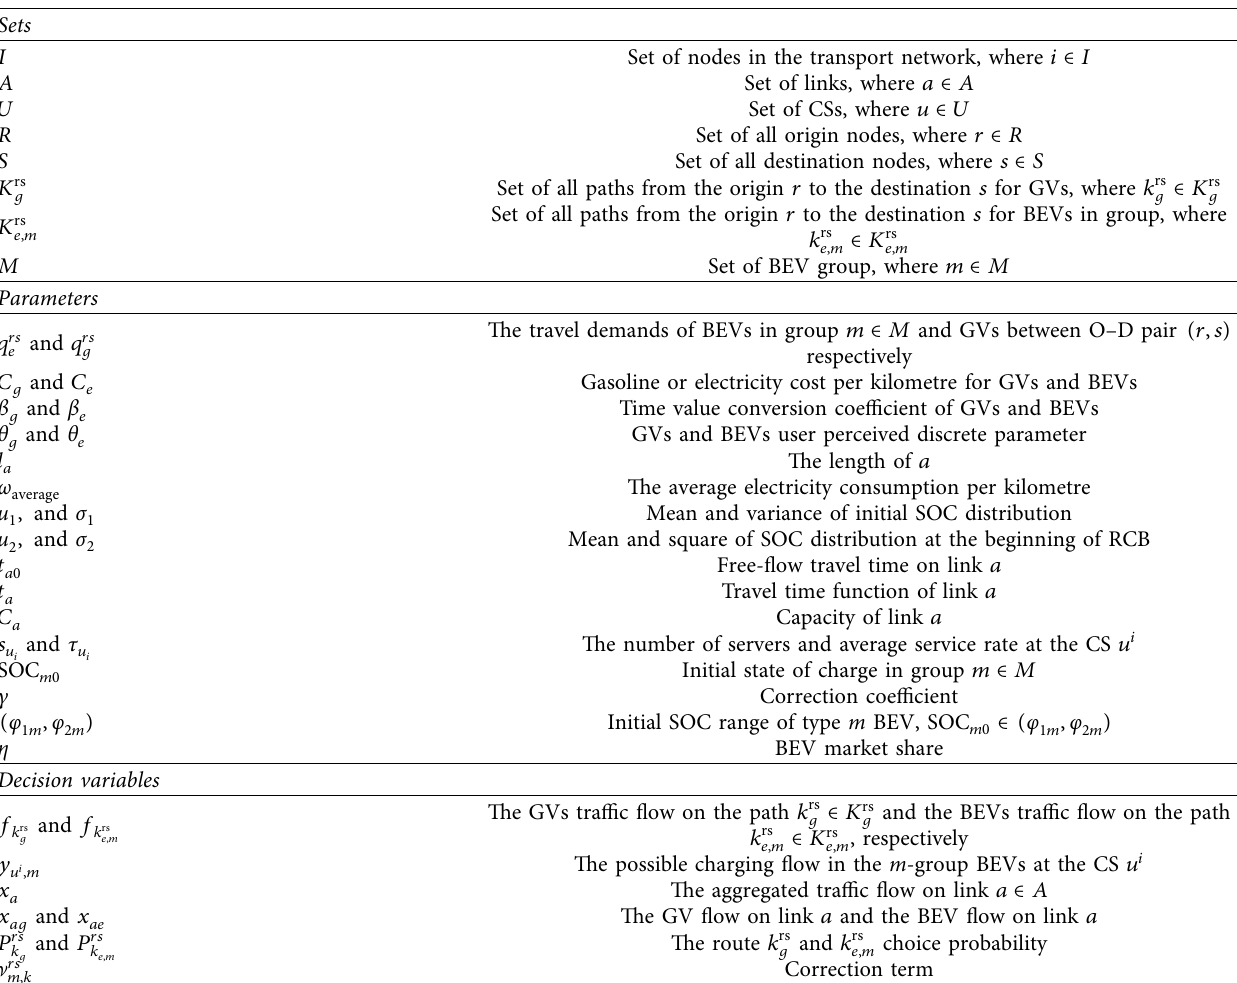
Figure 1: Recharging probability density. Table 2: